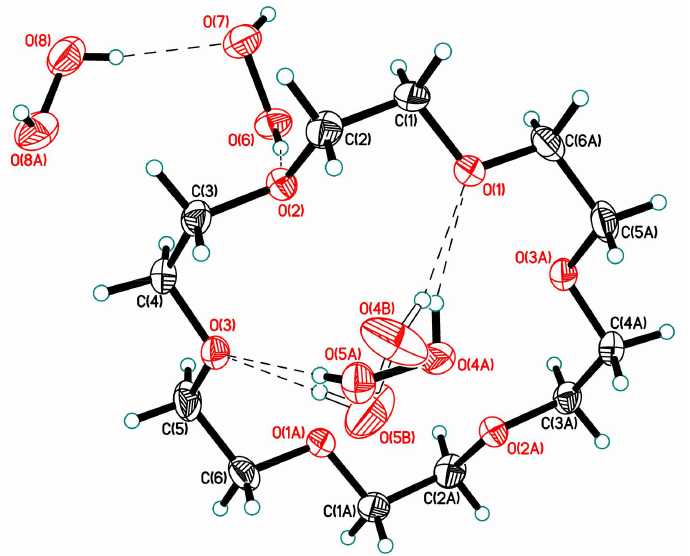
Figure 1. Asymmetric unit of I . Minor components of disorder are shown by open lines. Displacement ellipsoids are shown at the 50% probability level. The H-bonds are given by the dashed